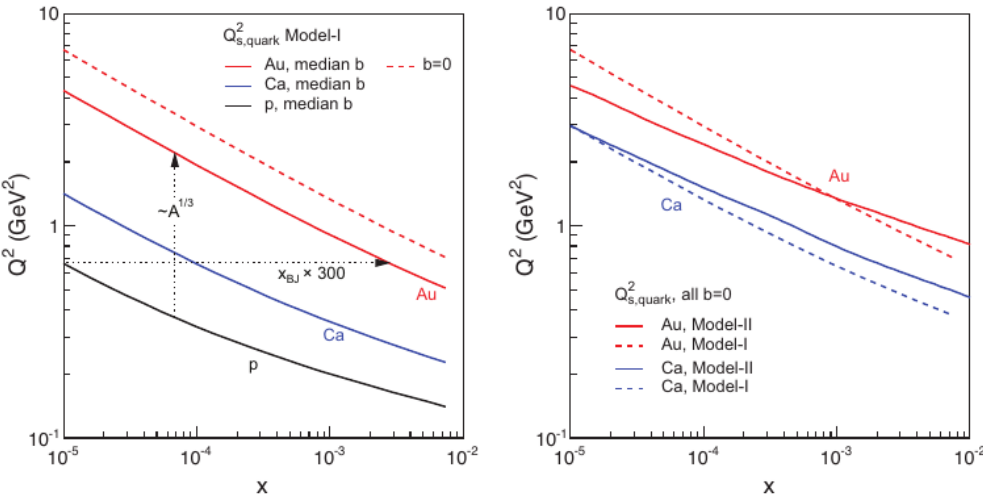
Figure 3. Theoretical expectations for the saturation scale as a function of Bjorken x for the proton along with Ca and Au nuclei. Q 2 s ∼ 7 GeV 2 is reached at x = 10 − 5 in e–p collisions at a √ s ∼ 60 GeV is needed to achieve comparable gluon density and the while in e–Au collisions, only same saturation scale; figure from